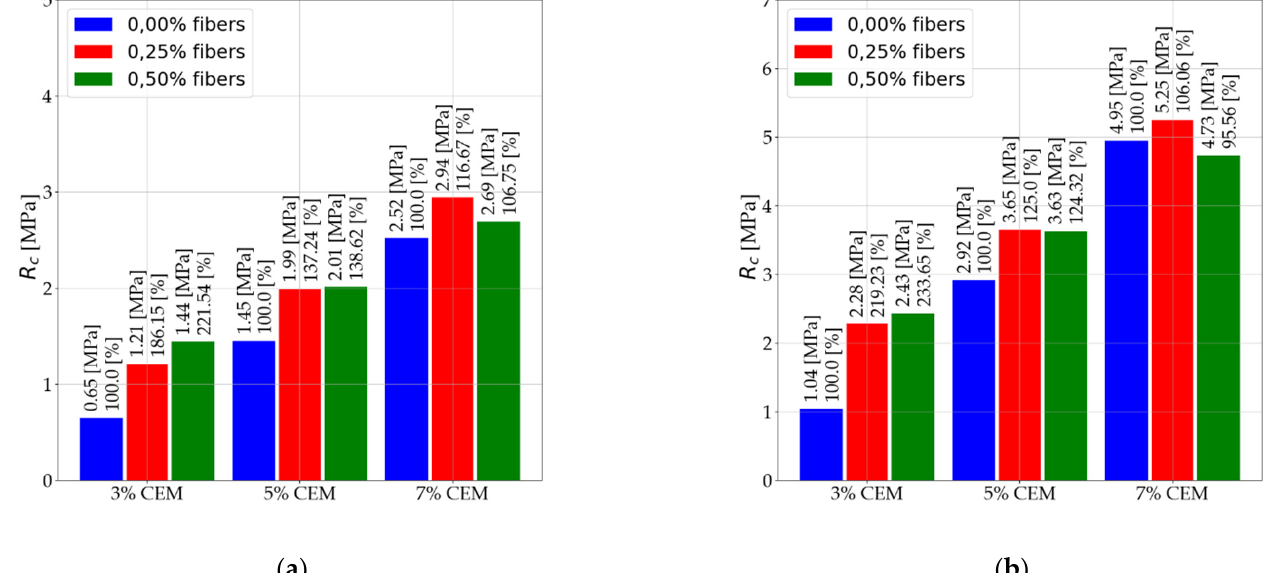
Figure 5. Unconfined compressive strength ( a ) after 7 days of care and ( b ) after 28 days of care. Table 6. Summary of unconfined compression strength results.